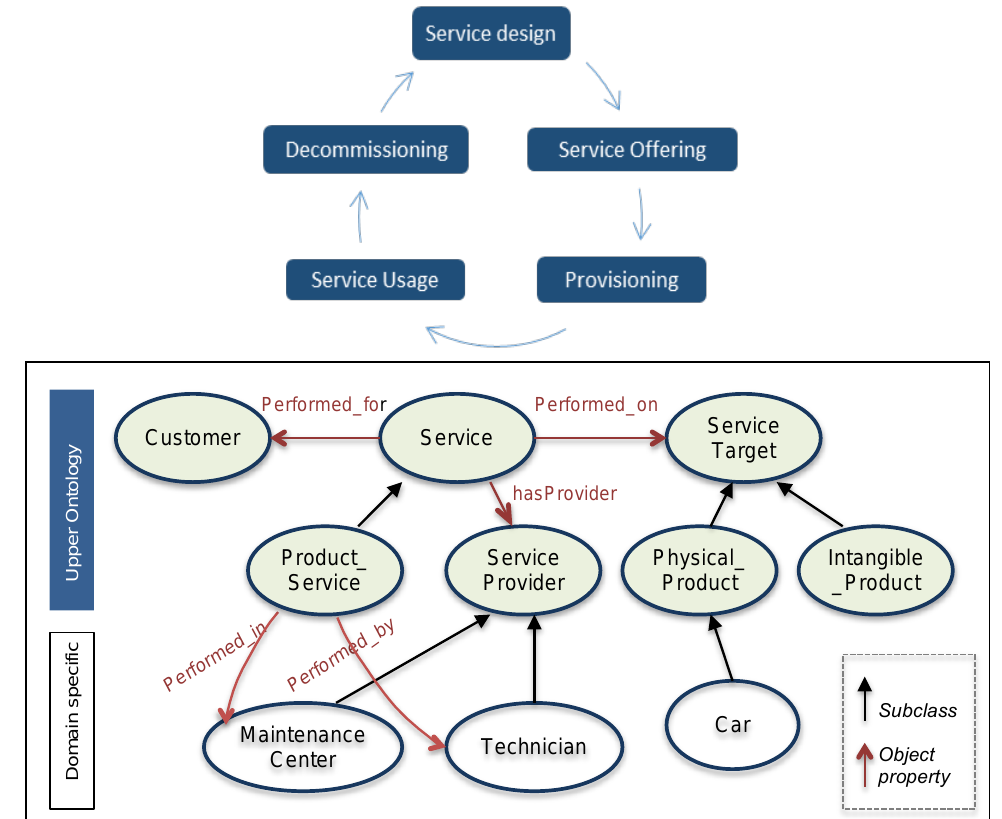
Figure 3. Service lifecycle phases and service upper ontology.